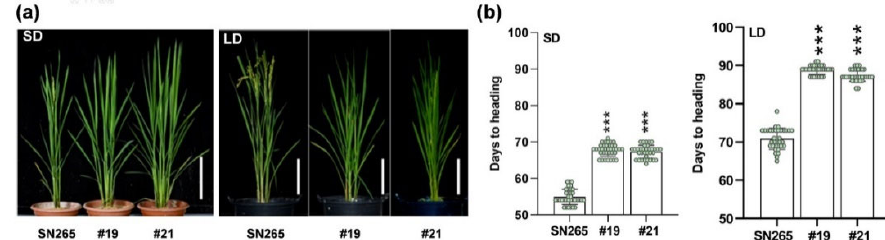
Figure 1. Double mutation of DTH2 and OSCO3 delayed heading of japonica rice under both SD and LD conditions. ( a ) Phenotypes of 60-d-old (the left panel) and 89-d-old (the right panel) plants of SN265 (wild type, japonica rice) and the double mutant dth2 - osco3 (two homozygous T 2 lines #19 and #21) growing under SD conditions (the left panel) and LD conditions (the right panel). Scale bars, 20 cm ( b ) Days to heading of SN265 and dth2 - osco3 lines under SD (the left panel) and LD (the right panel). Error bars represent SD of three biological replicates. Values are means ± SD. ***, p < 0.001.